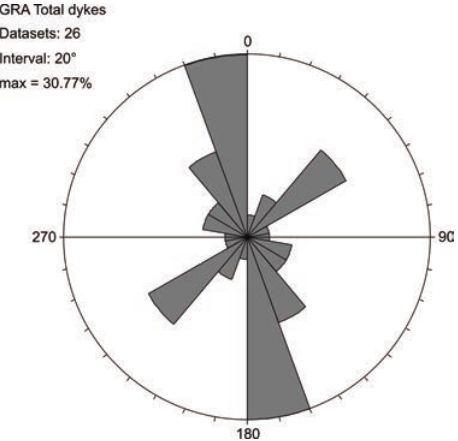
Figure 12. Geometry of all measured dykes: a) Circular histogram of unweighted frequencies of dykes’ plane directions. TectonicsFP software® [Ortner et al. 2002].